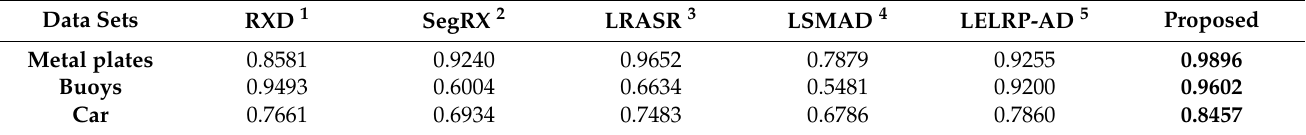
Figure 15. Receiver operating characteristic (ROC) curves. ( a ) ROC curves for the metal plates data set; ( b ) ROC curves for the buoys data set; and ( c ) ROC curves for the car data set. Table 1. Area under the receiver operating characteristic curve (AUC) scores for the different methods on the three data sets. Data